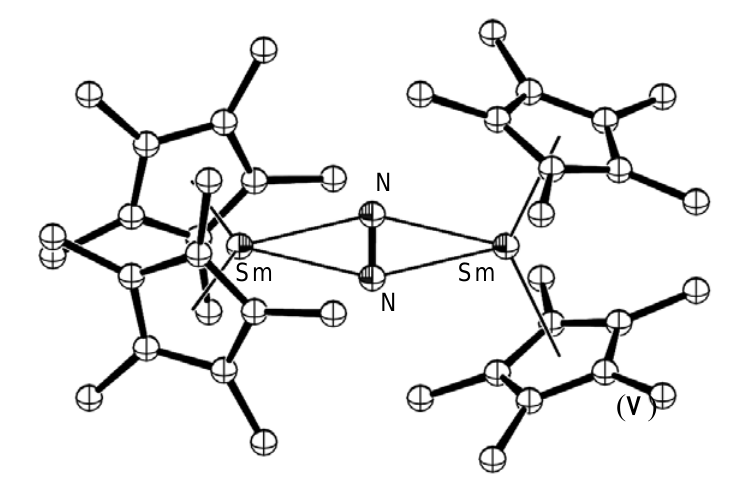
Figure 2. Molecular structure of side-on bound dinitrogen decamethylsamarocene complex V [34]. Figure generated from CCDC obtained coordinates. Atoms of arbitrary size. H atoms omitted for